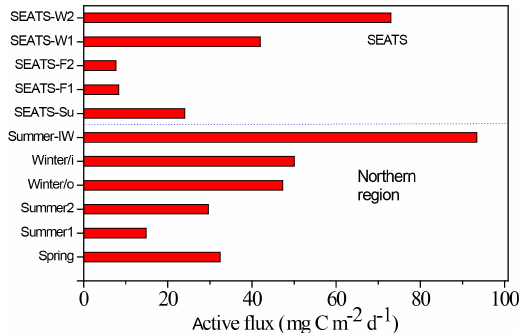
Figure 6. Comparisons between seasonal and spatial active car- bon fluxes in the NSCS. The active fluxes were geographically grouped as the central basin represented by the SEATS station and the northern region for other sampling locations. The SEATS active fluxes were estimated using the empirical relationship between ac- tive fluxes and inventories of Chl a except for SEATS-F1 and F2 (fall season), which were derived from experimental data. The data of the northern region were all experimental data, except for the Winter/o (outside the eddy) datum derived from the empirical rela- tionship between active fluxes and Chl a inventories. Winter/i (in- side the eddy); Summer-IW (internal waves); SEATS-Su (summer); SEATS-W (winter); SEATS-F